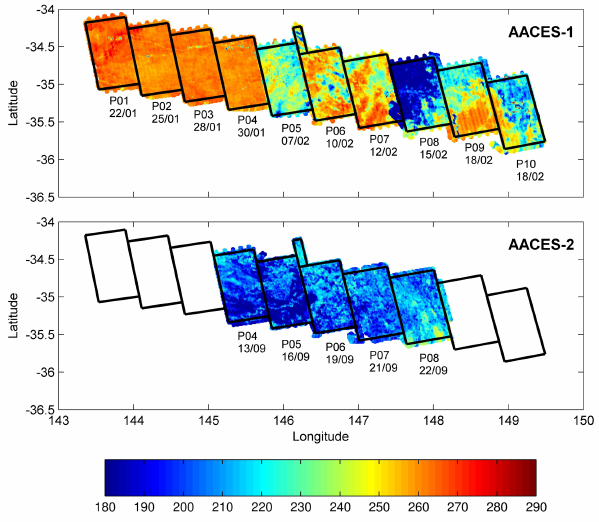
Fig. 6. Example of airborne L-band data collected at H-polarization during the summer (AACES-1) and winter (AACES-2) field cam- paigns with the brightness temperatures given in Kelvin. Note, each flight patch represents a single flight day.